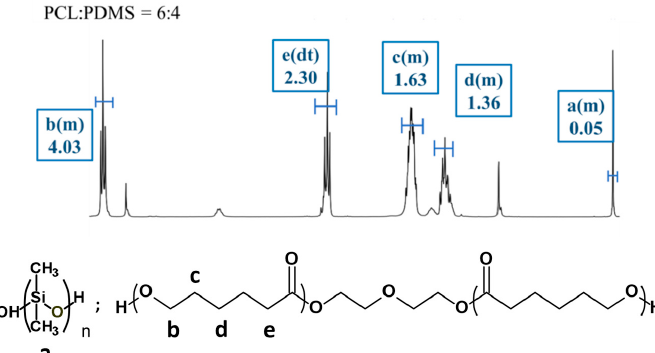
Figure 2. Compositional analysis of the PCL–PDMS copolymer nanofibres by 1 H NMR